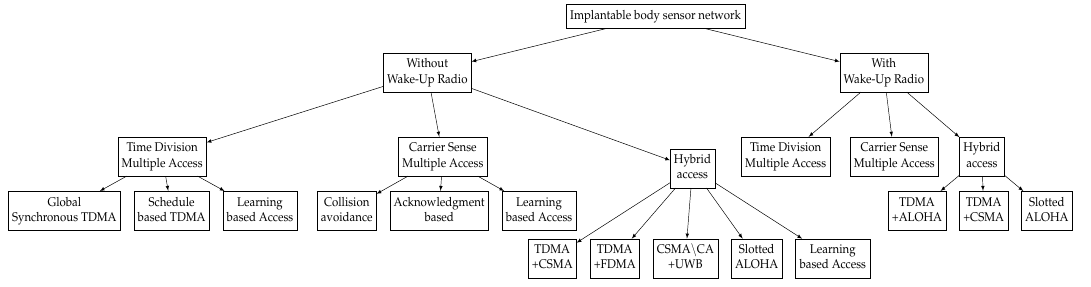
Figure 4. Taxonomy of MAC protocols based on their use of WuR technology. Table 6. TDMA-based MAC protocols without WuR and their drawback for